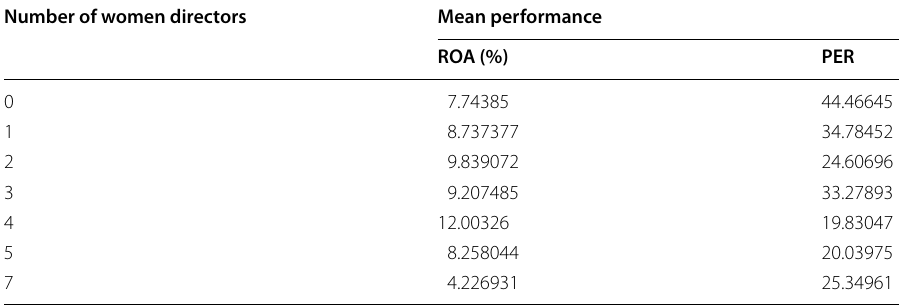
Table 4 Comparison among companies that have no women on board and those that have at least one woman on